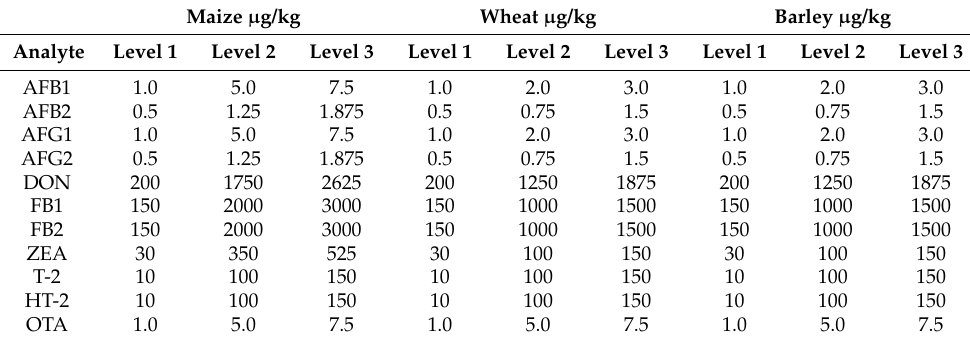
Table 3. Fortification levels for each mycotoxin and cereal